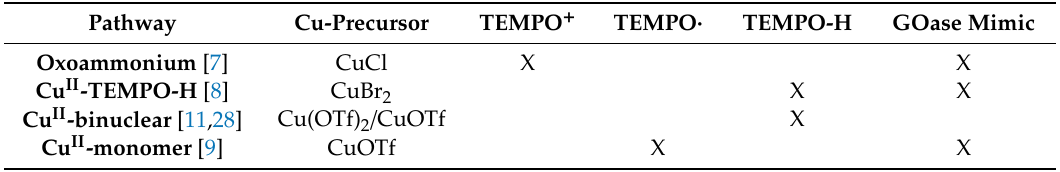
Table 3. A summary of the di ff erent mechanistic pathways for the aerobic alcohol oxidation. The Cu-precursor as well as the reactive intermediate for each pathway is indicated.